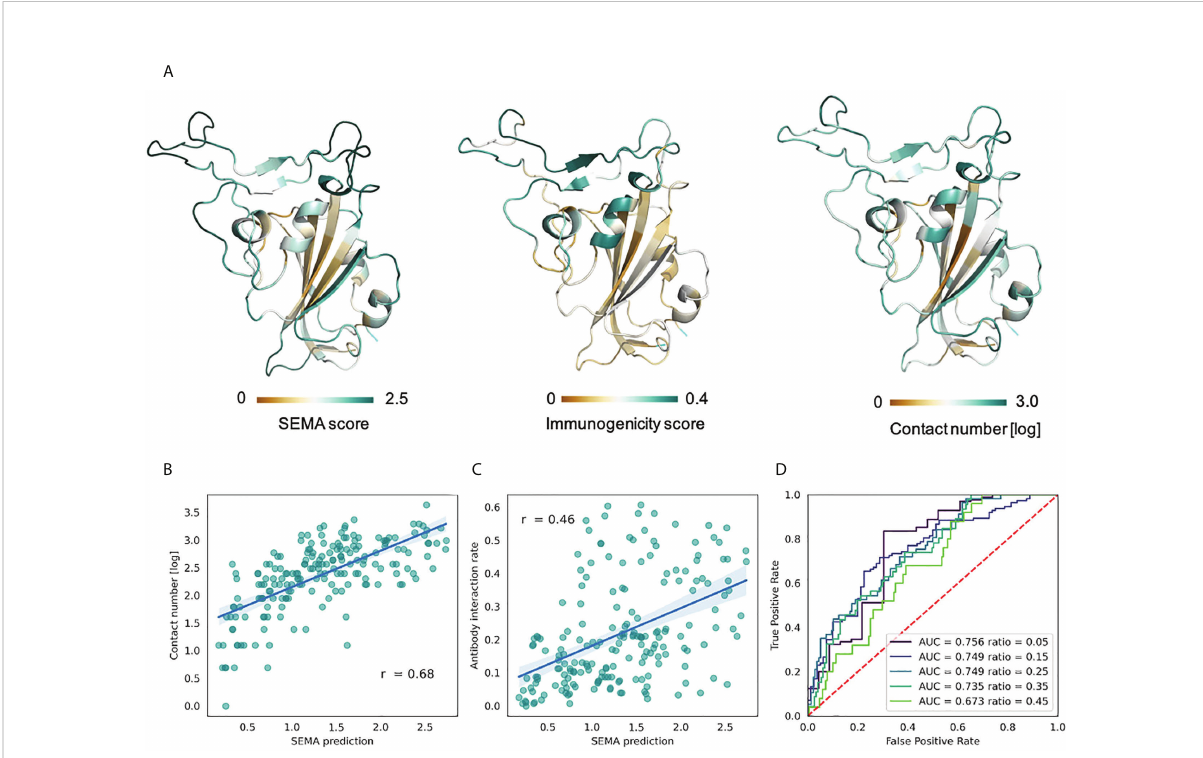
FIGURE 5 Prediction of RBD immunodominant epitopes with SEMA. (A) RBD domain of SARS-CoV-2 (PDB ID: 7KS9, chain B) colored according to the SEMA predicted score (left), immunogenicity score (center) and contact number values (right). Residues colored from brown (low value) to cyan (high value). Immunogenicity was estimated as the ratio of RBD/antibody complexes in the PDB database in which RBD residue was in contact with antibody within 8.0 (Å) (B) Correlation between the SEMA score and the log-scaled antigen contact number feature. Pearson correlation coef fi cient is shown. (C) Correlation between the SEMA score and the immunogenicity score. Pearson correlation coef fi cient is shown. (D) ROC AUC values calculated for different epitope/non-epitope residue classi fi cation based on the immunogenicity score threshold. ROC AUC values and threshold values for classi fi cation are